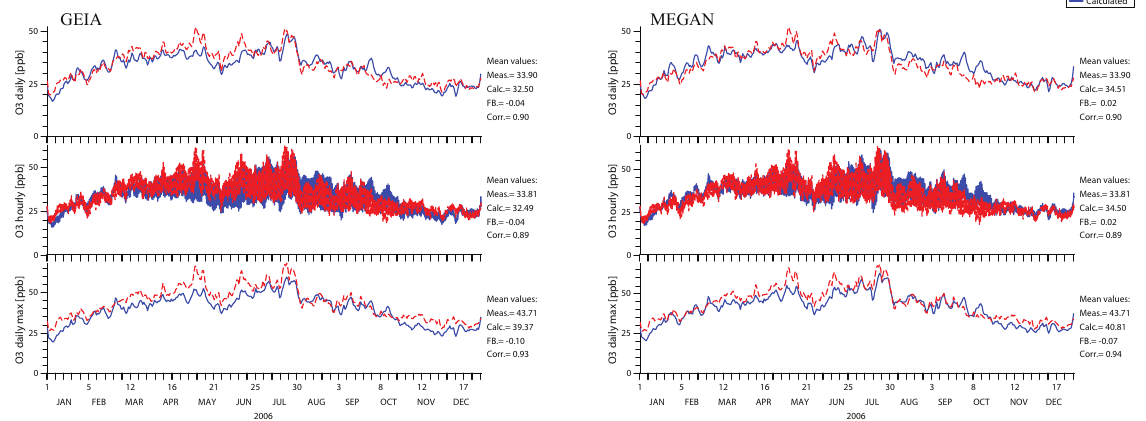
Fig. 13. Evaluation of the DEHM model results for daily mean, hourly and daily maximum ozone concentrations using both the GEIA and MEGAN isoprene emission models for 2006 against available measurements from the EMEP network in